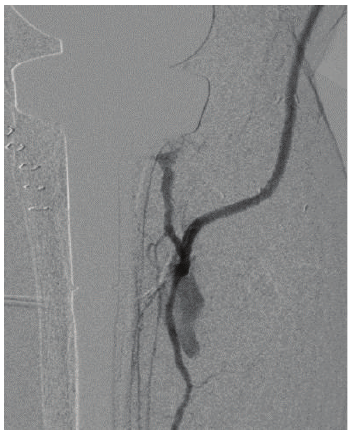
Figure 4: Arteriography of right knee (after bypass grafting) showing the recovery of lower limb